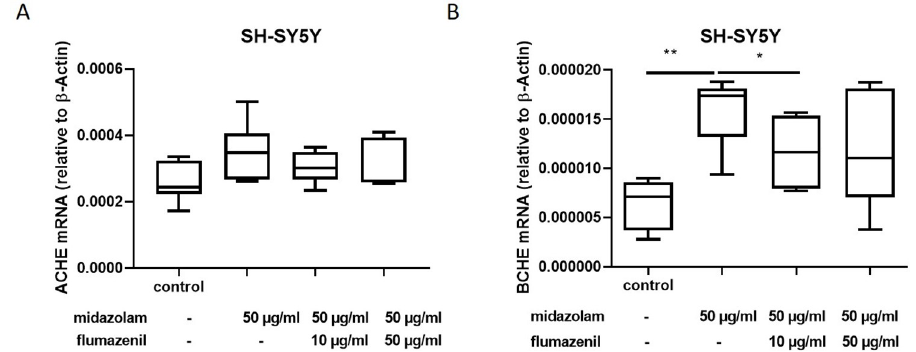
Fig 2. SH-SY5Y cells were incubated with midazolam for 24 h and with flumazenil (starting 2 h after midazolam exposure) for 22 hours. ACHE and BCHE mRNA expression relative to β -Actin mRNA expression were quantified by qPCR. Incubation with flumazenil A) did not alter ACHE expression (n = 6; p = n.s.) and reduced B) BCHE (n = 6; p = 0.046) expression. Data are presented as mean ± standard deviation. The reported p-value refers to the Dunnett’s post-hoc test, comparing the underlying columns at the ends of each